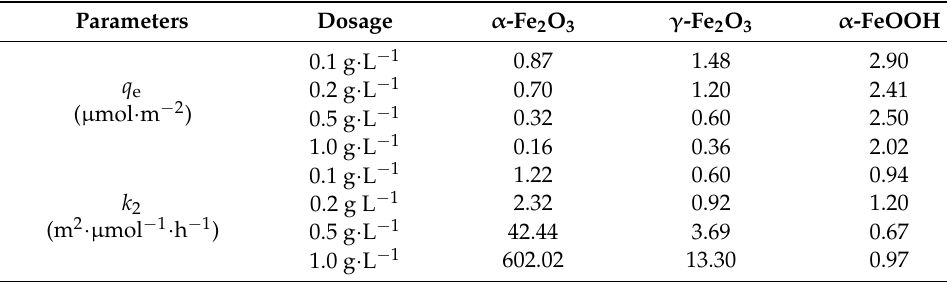
Figure 2. Adsorption kinetics of p -arsanilic acid (ASA) on α -Fe 2 O 3 , γ -Fe 2 O 3 , and α -FeOOH. The solid points are exper- imental data. The polylines in ( a – c ) are for the visual guides. The curves in ( d – f ) are the fitted results according to the pseudo-second-order kinetic model. ASA = 20 µ M, NaCl = 10 mM, and pH = 5. Table 1. Fitted parameters for ASA adsorption on iron